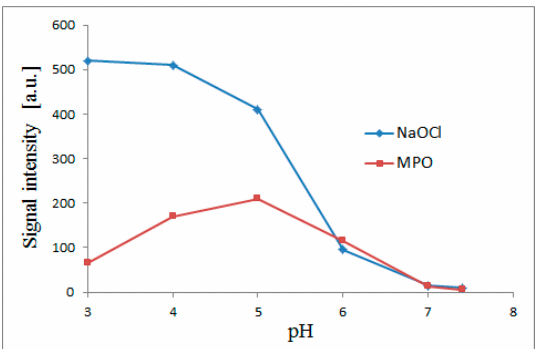
Figure 2. Betanin chlorination activities of the chemical (NaOCl) and enzymatic (MPO + H 2 O 2 + Cl − ) systems obtained by LC-MS quantification of generated chlorinated betanin 1a in dependence on pH in each tested system. Table 2. High-resolution mass spectrometric data obtained by LCMS-IT-TOF for monochlorinated betanin ( 1a ) and its decarboxylated derivatives ( 2a , 3a , 4a, and 6a ) as well as for their fragmentation ions.